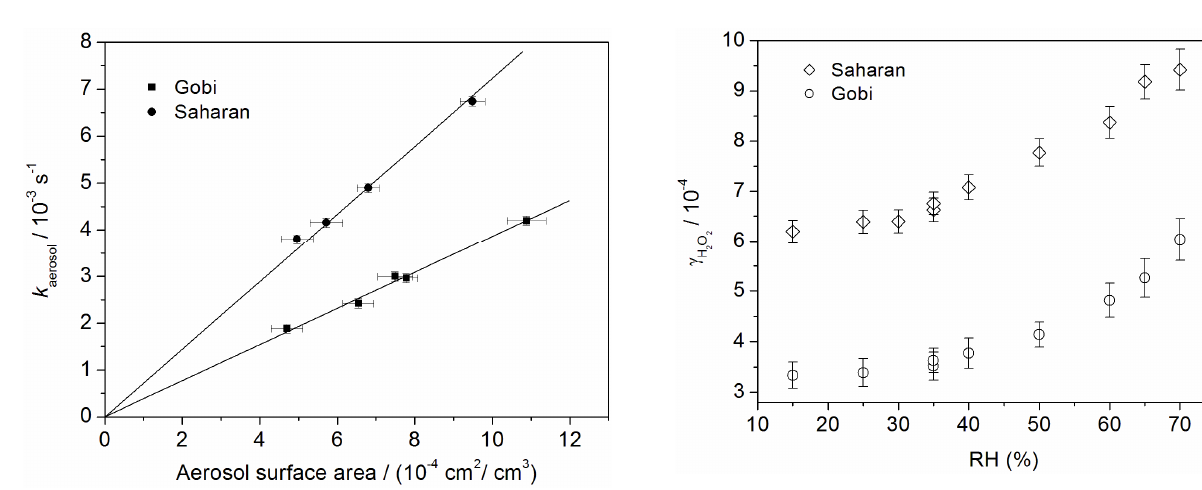
Fig. 4. Aerosol surface area, S a , versus the first-order rate constants for loss of H 2 O 2 to the aerosol k aerosol at 35% RH. The calculated uptake coefficients from the gradients of this plot are γ H =(3.63 ± 0.24) × 10 − 4 for the Gobi dust and γ H =(6.76 ± 0.22) × 10 − 4 for the Saharan dust. The lines repre- sent 2 σ error-weighted least-squares fits forced through the origin.